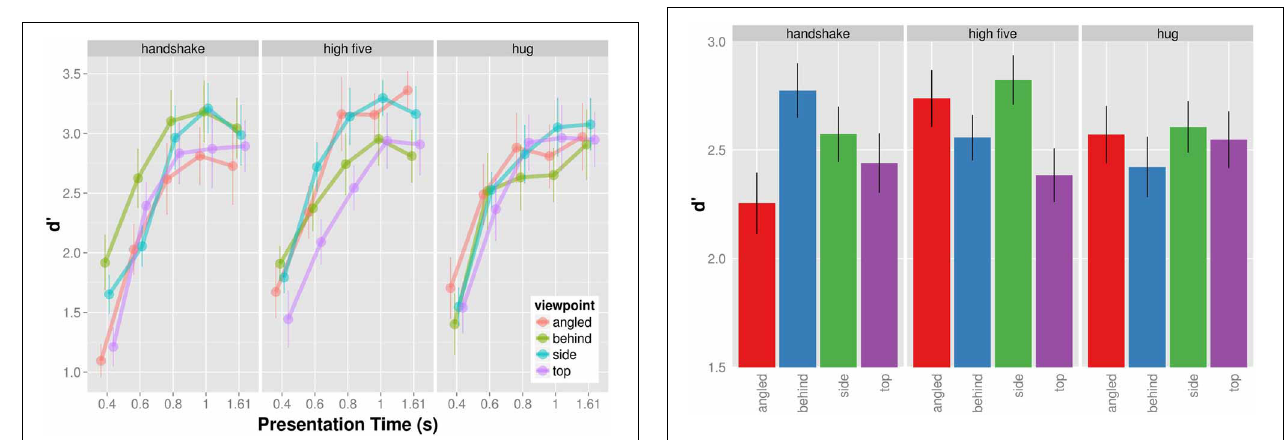
FIGURE 5 | Mean d (cid:2) given for each action and viewpoint separately (collapsed across presentation duration). Bars indicated one standard error from the